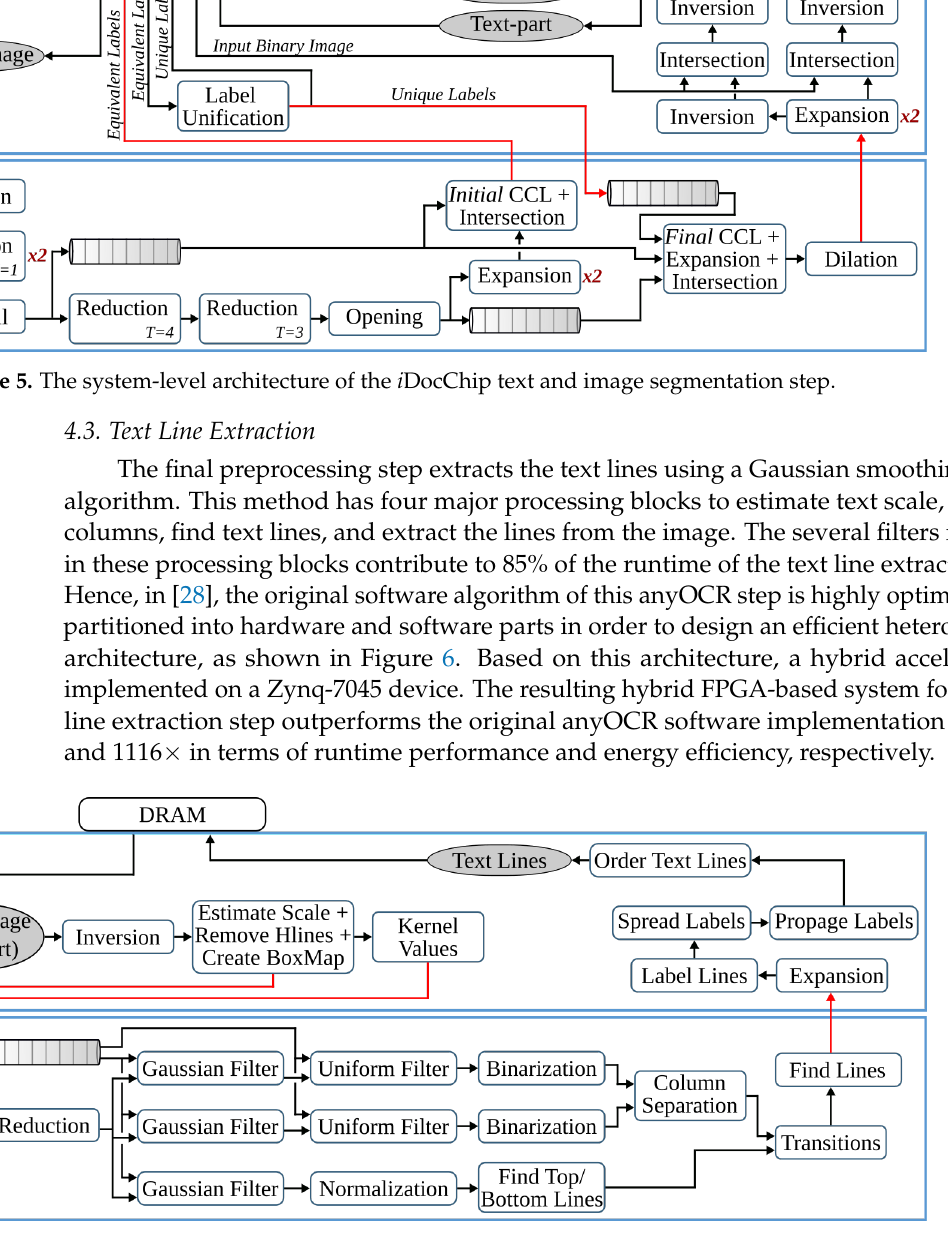
Figure 6. The system-level architecture of the i DocChip text line extraction